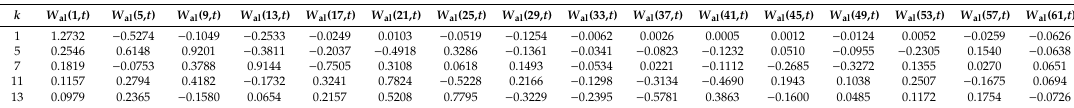
Table 3. Walsh coe ffi cient matrix